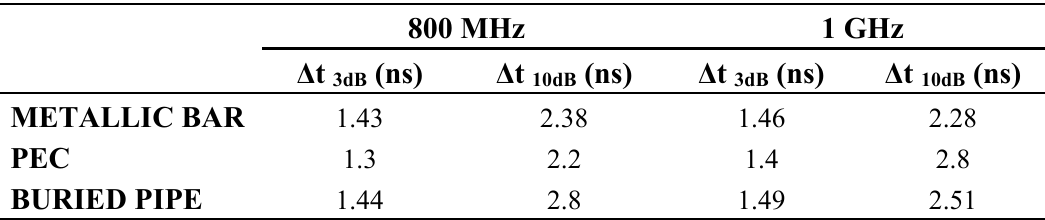
Table 1 . Time intervals between values of 1/2 (corresponding to 3 dB) and 1/10 (corresponding to 10 dB) with respect to the recorded maximum amplitude of the wavelet obtained in the different experiments for both antennas. Measurements were obtained with high stacking (512) to ensure adequate signal stability.